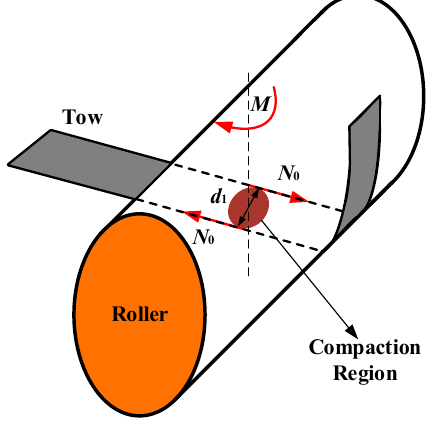
Figure 5. Schematic diagram of the tangential contact.